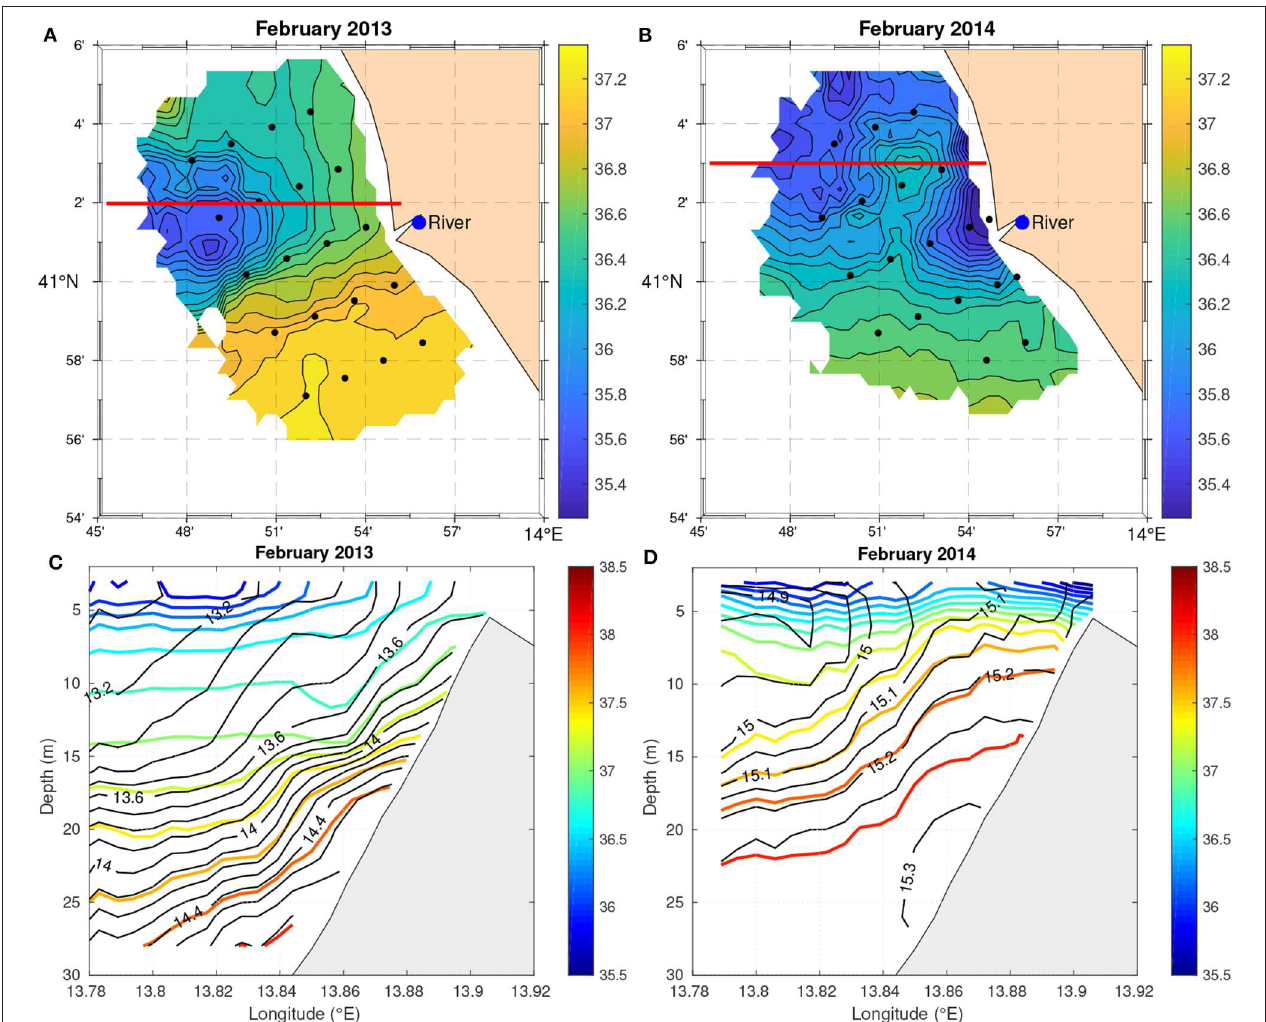
FIGURE 9 | OA maps of salinity ( g kg − 1 ) at 3 m (A,B) in February 2013 (left panel) and February 2014 (right panel). The fields are not plotted where the OA expected error exceeds 20 % . The contour interval is 0.1 g kg − 1 . Dots indicate location of stations. In (C,D) , the vertical isolines of temperature (in black, contour interval 0.1 ◦ C in C and 0.05 ◦ C in D ) and salinity (colored, contour interval 0.2 g kg − 1 ) are shown along the 41 ◦ 02’N and 41 ◦ 03’N parallels (red lines), respectively.